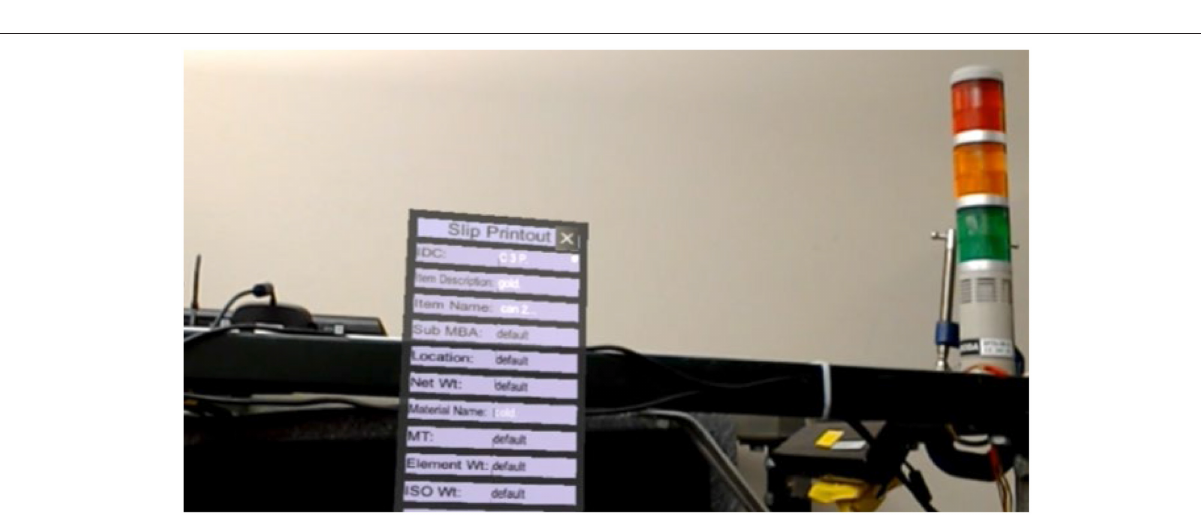
FIGURE 23 | Changes to two fields in the documentation have been made in a hands-free manner using the voice recognition